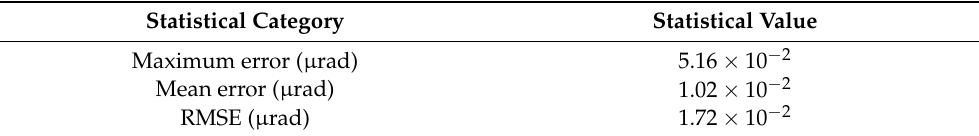
Figure 5. The calculation errors of the MO-based model for ABP determination. ( a ) The variation of the ABP calculation error within one complete 360 ◦ scan cycle of the ECF. ( b ) The histogram of the ABP calculation errors. Table 1. The statistical summary of the ABP calculation errors of the MO-based model.